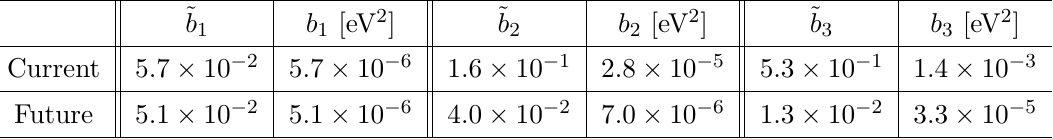
and b i at 1 σ confi- i